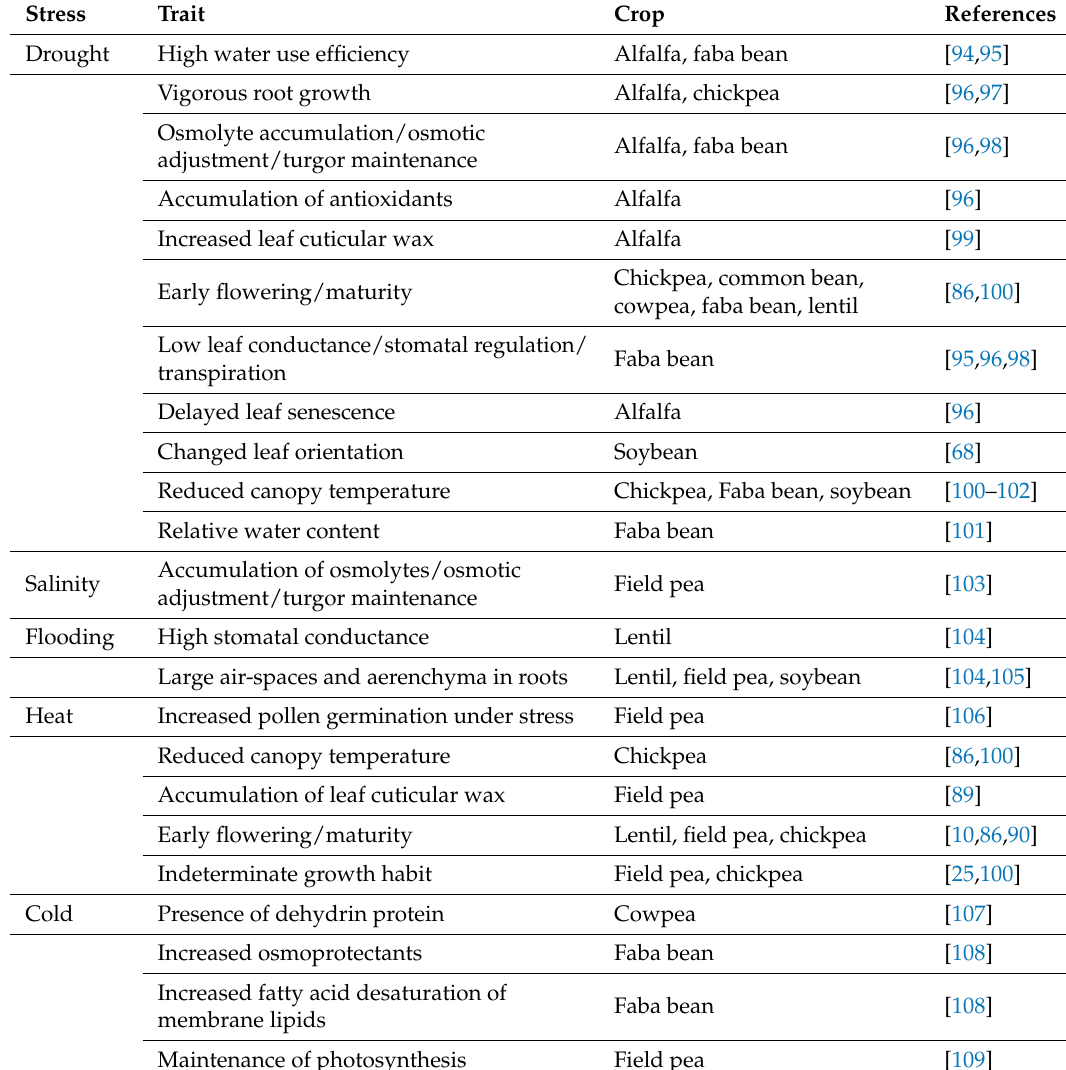
Table 2. Adaptive traits related to abiotic stresses in legume